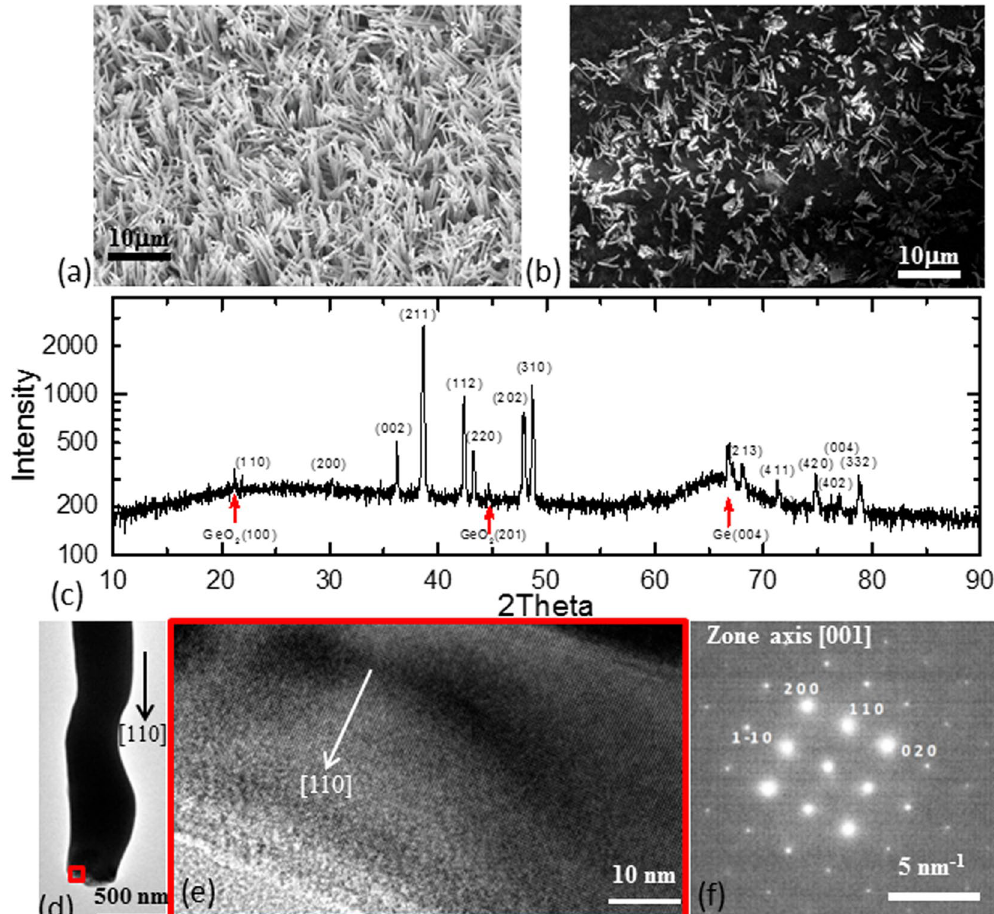
Figure 1. Structure of the nanowires. ( a ) SEM image of nanowires on Ge substrate, shows majority of the wires were vertically grown on the substrate. ( b ) SEM image of nanowires after transferred to carbon tape, shows wire were aligned on the tape. ( c ) X-ray diffraction pattern measured from the nanowires on Ge wafer, matches FeGe 2 as indexed in the figure. Red arrows mark the Ge (004) peak of the substrate and impurity peaks identified as GeO 2 (100) and (201). ( d ) and ( e ) TEM images from single nanowire. ( e ) is the zoom in of the red rectangle area in ( d ). ( f ) The electron diffraction pattern of ( e ), it identified that the structure matches space group I4/mcm and long axis direction of nanowires is along [110].